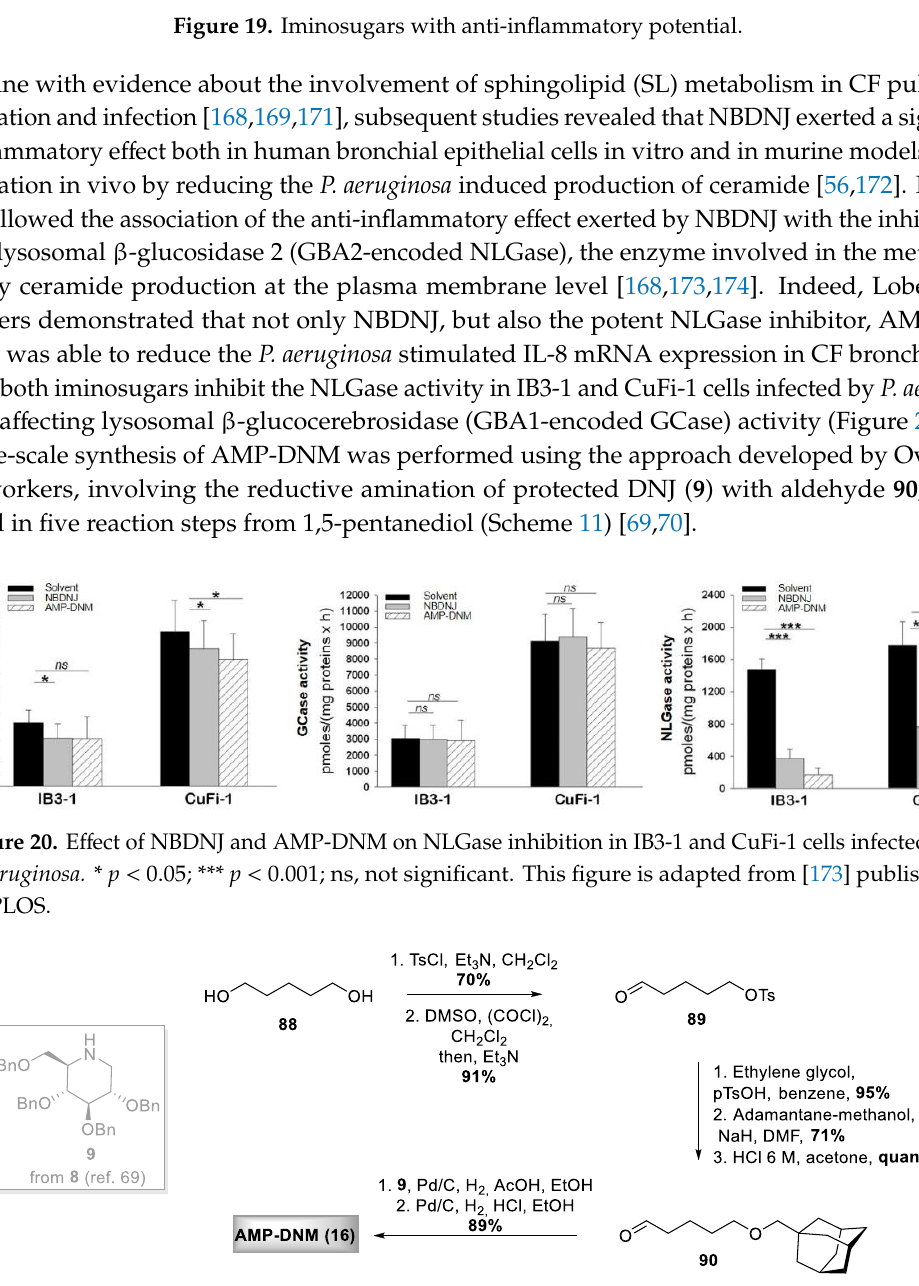
Scheme 11. Synthetic route to AMP-DNM [69,70].